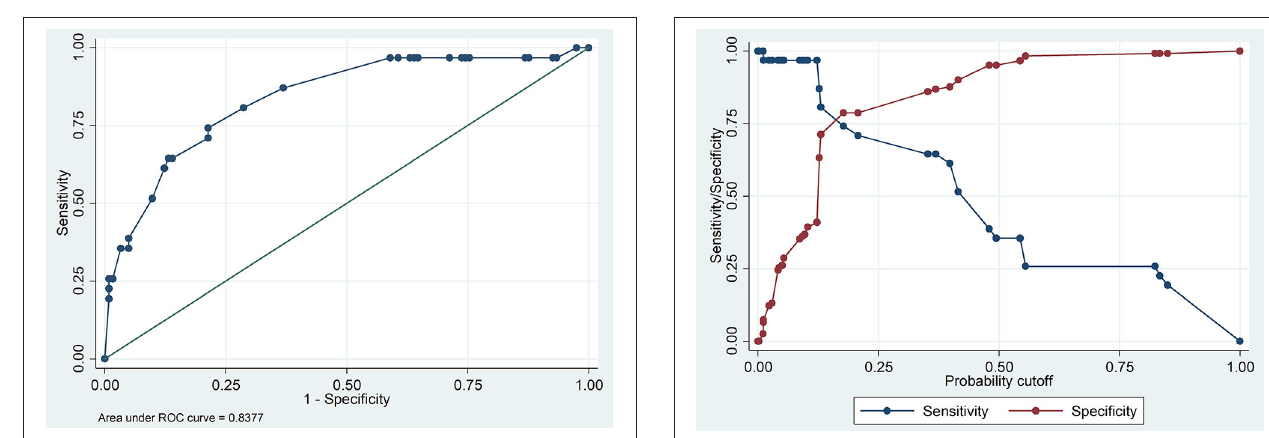
FIGURE 2 | ROC curve demonstrating predictability of the model. FIGURE 3 | Graphs demonstrating probability cutoff vs. sensitivity and